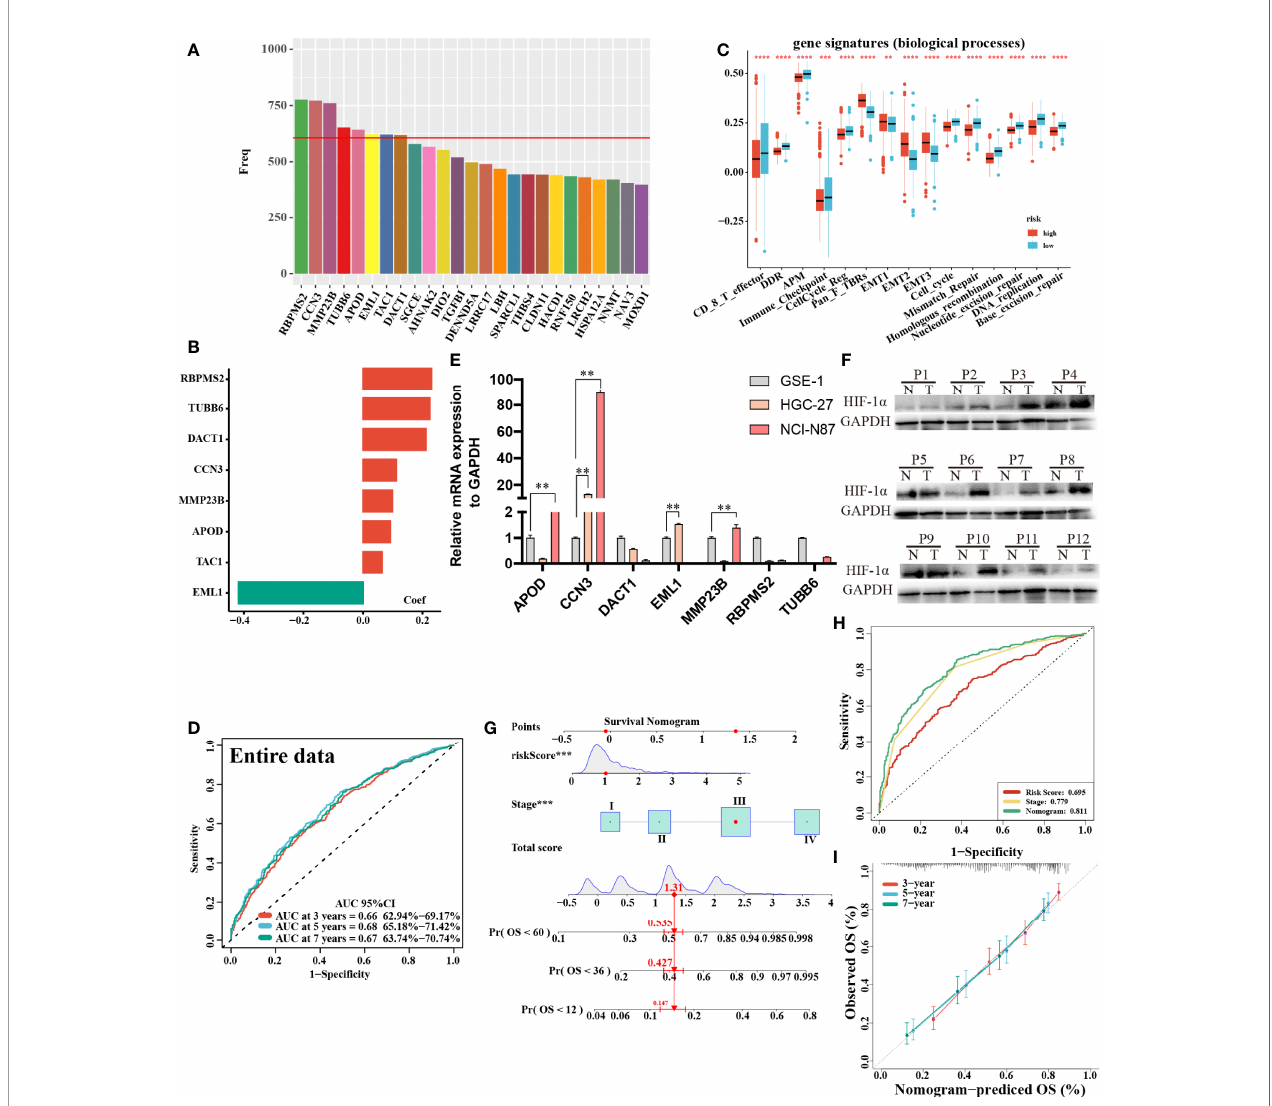
FIGURE 5 | Construction and validation of signature and nomogram. (A) The best candidate predictive genes were selected to construct the signature according to the frequency of genes by Lasso-bootstrapping that was de fi ned more than 600 times in 1,000 times replications. (B) The coef fi cient value of the 8 selected genes came from the stepwise multivariate Cox regression analysis. (C) The difference of core biological processes was evaluated between high- and low-risk patients that were divided according to the optimal cut-off value. The lines in the boxes represented the median value. (D) The area under the ROC curves (AUC) of the entire data were 0.66 (62.94% – 69.17%, 95%CI), 0.68 (65.18% – 71.42%, 95%CI), and 0.67 (63.74% – 70.74%, 95%CI) at 3, 5, and 7 years, respectively. (E) qRT-PCR results of MRHPPG expression level in GSE-1 and GC cell lines. (Data are presented as mean ± SD., **P < 0.01). (F) Western blot analyses of HIF- a protein levels in total cell lysates from paired clinical specimens of normal (N) and tumor (T) tissues from 12 patients with GC. (G) A survival nomogram of 3-, 5-, and 7-year OS was drawn in view of the risk score and stage. (H) AUC for risk score, stage, and nomogram reached at 0.659, 0.779, and 0.811, respectively, which mean a high accuracy to be a reliable method. (I) The calibration curve of nomogram showed a favorable result in 3, 5, and 7 years. (***P < 0.001,****p <